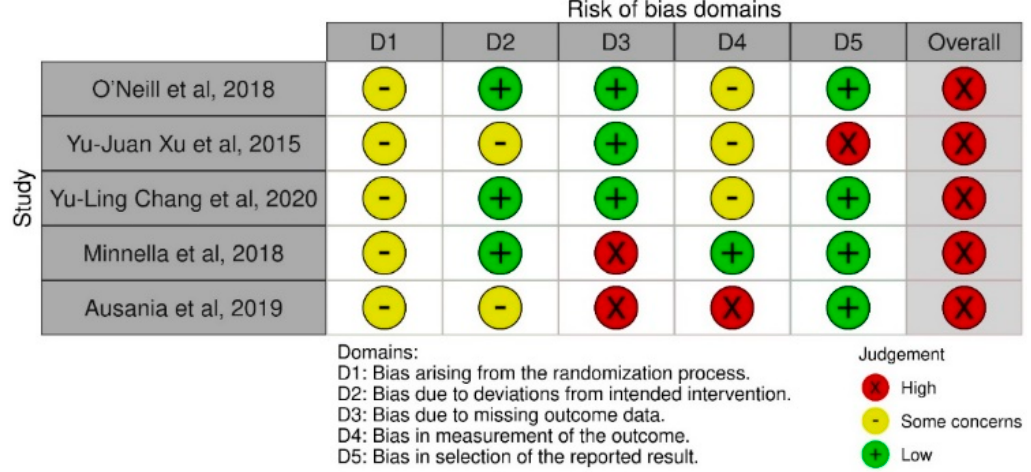
Figure 2. Risk of bias assessment. Risk of bias completed using the revised Cochrane Risk of Bias tool (RoB2).